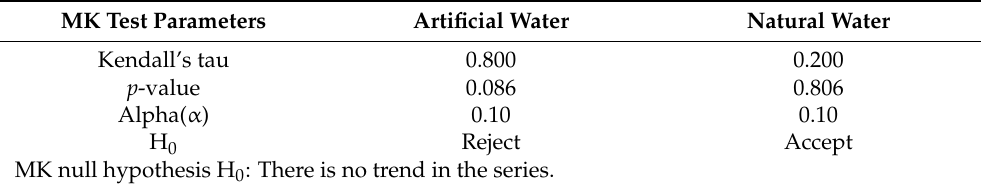
Table 3. MK test results for the area of artificial and natural water bodies, 2000–2020.